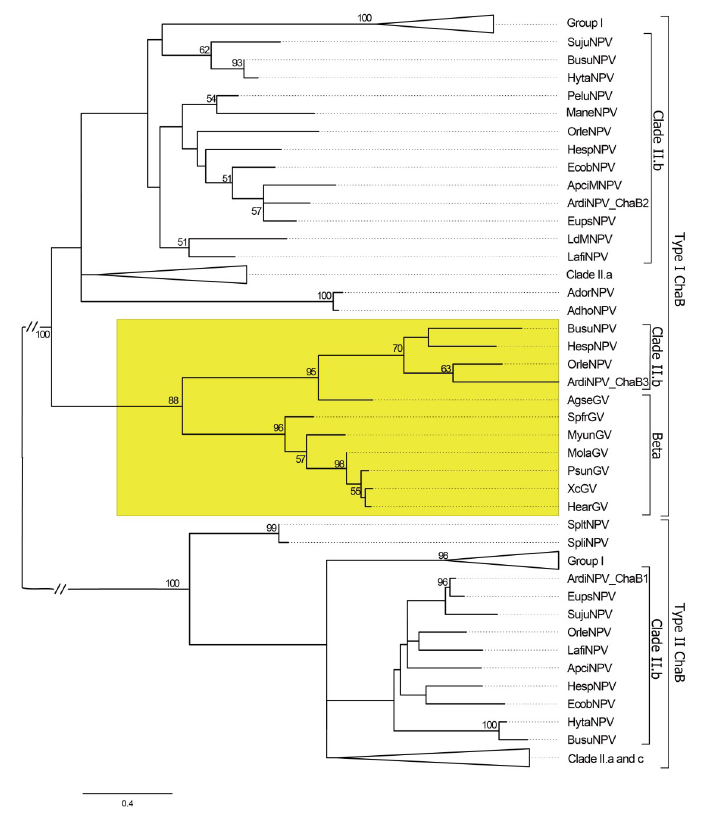
Figure 4. Phylogeny analysis of the baculovirus ChaB protein. The phylogenetic tree was constructed using the available baculovirus ChaB proteins by the Maximum Likelihood method with 1000 bootstrap values. Values of more than 50 are shown on the branch. The taxonomy lineages of the viruses and the types of ChaB are indicated on the right. The lineage of the third ChaB of ArdiNPV, BusuNPV, HespNPV, and OrleNPV and that of GVs is markered with a yellow